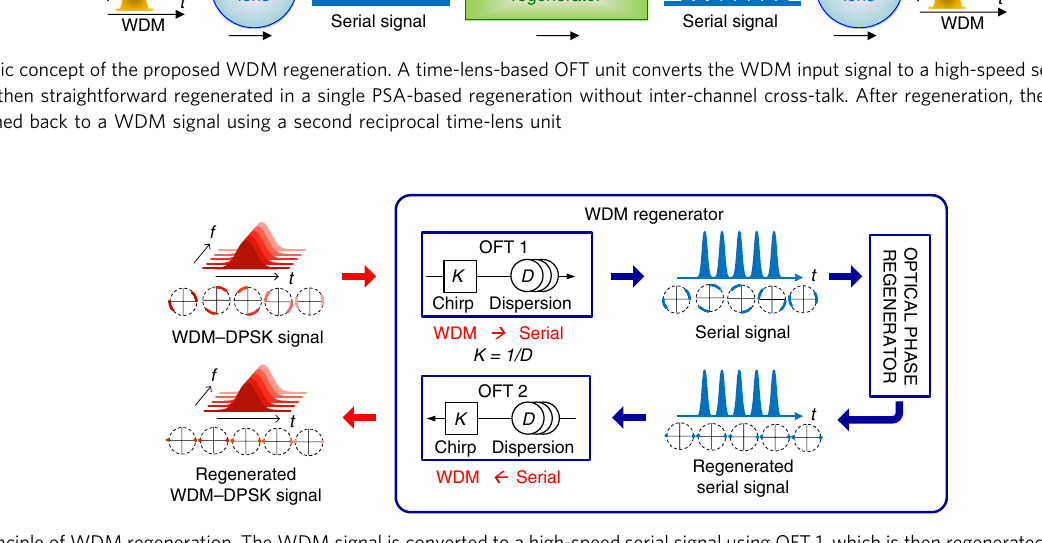
Fig. 2 Principle of WDM regeneration. The WDM signal is converted to a high-speed serial signal using OFT 1, which is then regenerated in a single optical phase regenerator. After regeneration, the serial signal is converted back to a WDM signal using OFT